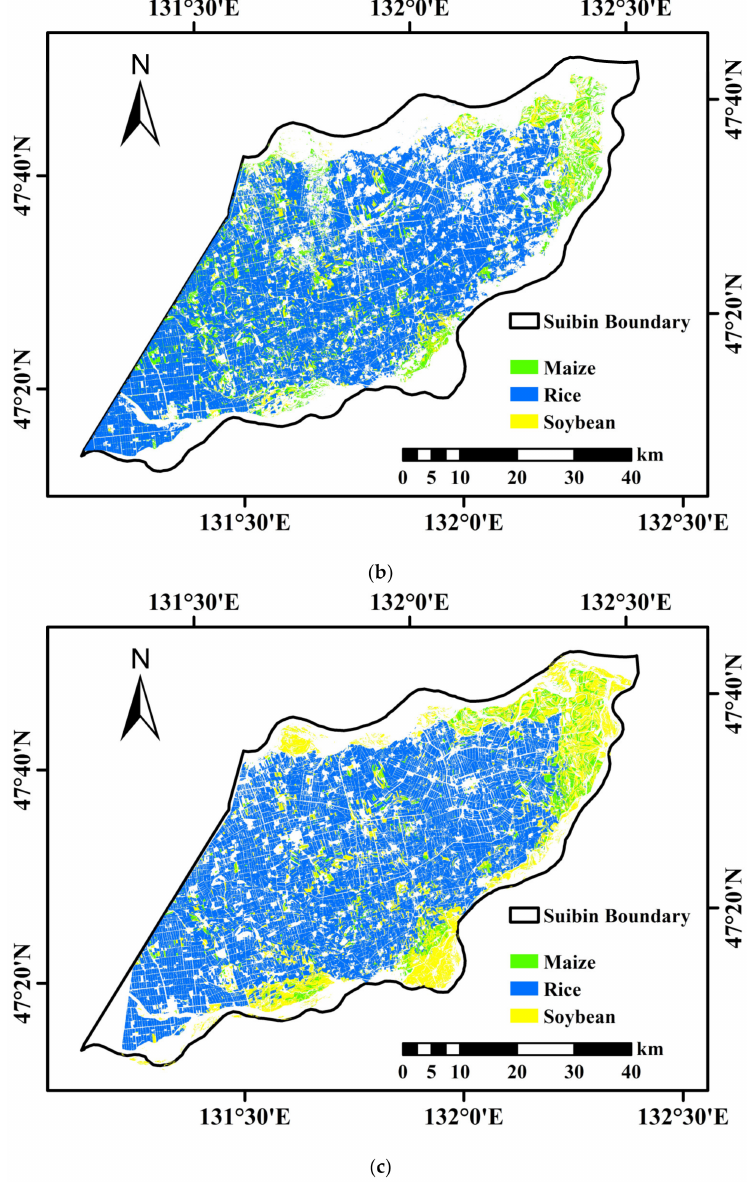
Figure 13. ( a ) Distribution of the main crop cultivation area in Suibin County in 2018. ( b ) Distribution of the main crop cultivation area in Suibin County in 2019. ( c ) Distribution of the main crop cultivation area in Suibin County in